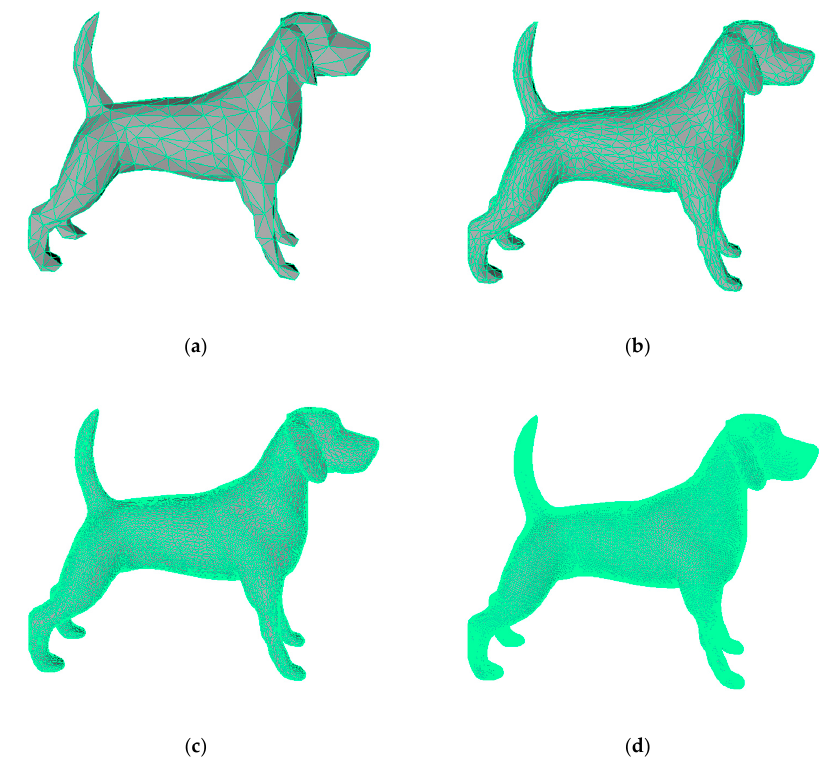
Figure 1. Dog model with different vertices and faces. ( a ) 502 vertices and 1000 faces, ( b ) 2002 ver- tices and 4000 faces, ( c ) 10,002 vertices and 20,000 faces, ( d ) 49,714 vertices and 99,424 faces.